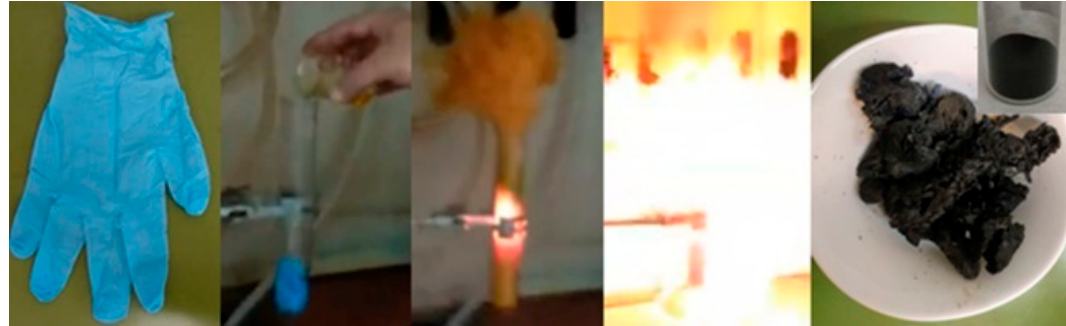
Figure 1. Fuming nitric acid causes ignition of nitrile glove, leading to the formation of carbon foam (far-right photo). Crashing and purification of the foam gives a fine powder composed of carbon nanosheets (far-right inset).